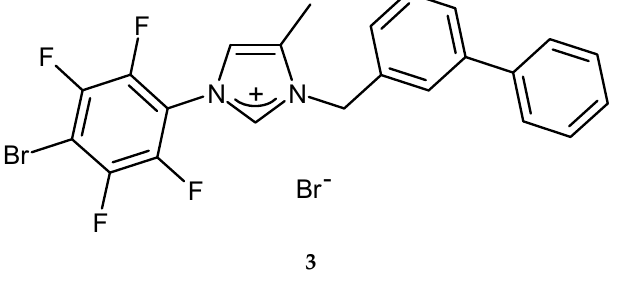
Figure 3. Structure of cation 2 indicating the positions of the closest bromide anions. Thermal ellipsoids are at the 50% level. Hydrogen atoms, except those involved in hydrogen bonding, are omitted for clarity.